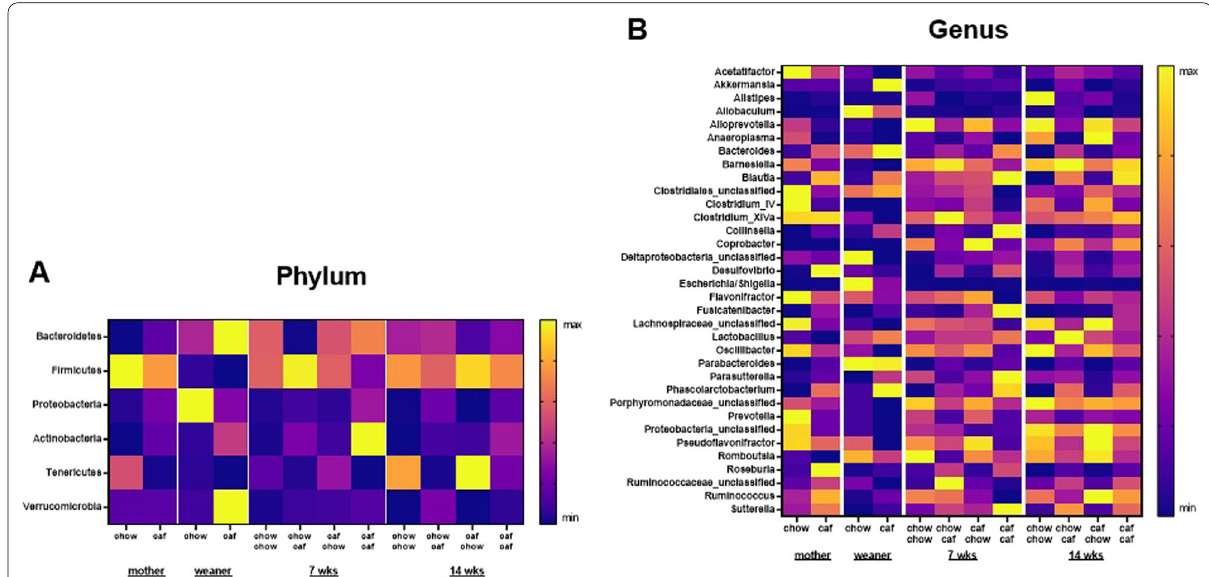
Fig. 4 Representative taxa on the phylum and genus levels in each group. Microbial taxa top 100 OTUs were selected to generate heat maps on phylum level (A) and genus level (B) . The relative abundance of phylum and genus levels were normalised by